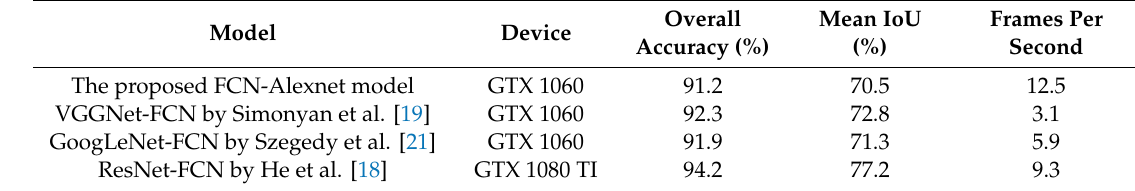
Table 1. Comparisons of the proposed FCN-Alexnet with other mainstream network